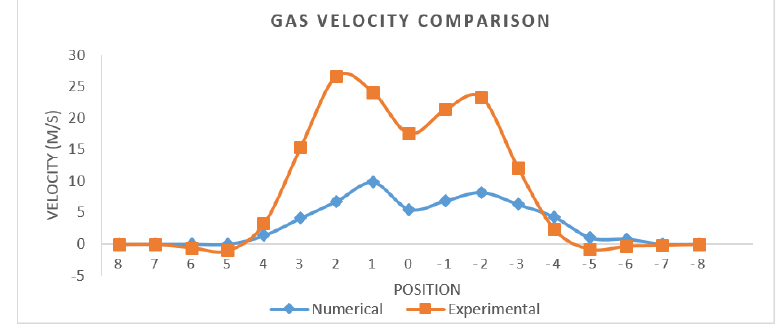
Figure 18: A comparison of numerical and experimental gas velocity values at 10 mm distance from the